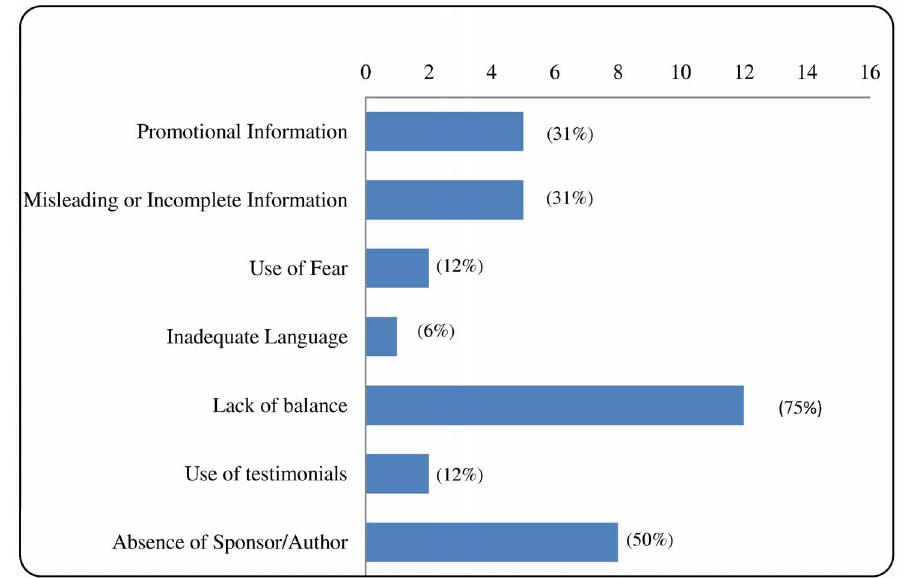
Figure 1. Non-compliance of disease awareness campaigns (n=16) per key criteria. Fifteen out of the sixteen materials assessed were non- compliant with the guidelines. Non-compliance was more frequent due to lack of balance, absence of listed author and/or sponsor, use of promotional information and use of misleading or incomplete information. doi:10.1371/journal.pone.0106599.g001 PLOS ONE |